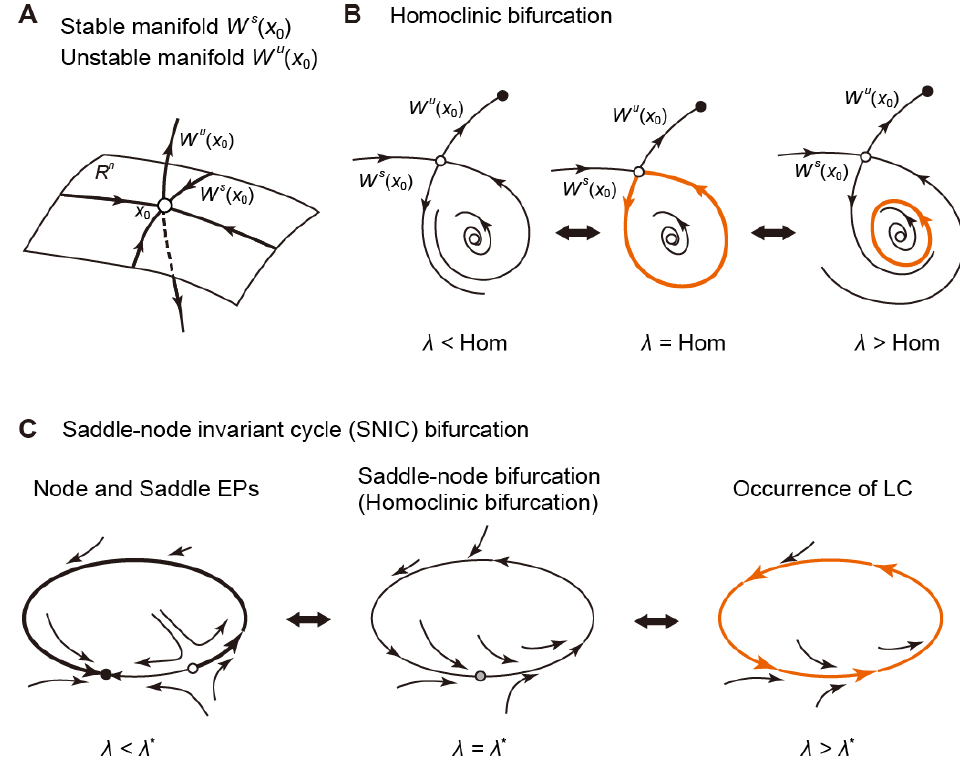
Figure 8. Bifurcation phenomena associated with stable and unstable manifolds of an equilibrium point. ( A ) A schema of stable and unstable manifolds of the equilibrium point x 0 in the state space. W s ( x 0 ), stable manifold; W u ( x 0 ), unstable manifold. ( B ) Homoclinic bifurcation. When the parameter λ becomes the value of Hom, the stable and unstable manifolds of the equilibrium point x 0 coincide, giving rise to a closed-loop orbit, which is referred to as “homoclinic orbit”. This closed-loop orbit is vulnerable to changes in the parameters and breaks down immediately. ( C ) Saddle-node invariant cycle bifurcation. At the bifurcation parameter value λ *, saddle-node and homoclinic bifurcations occur simultaneously.